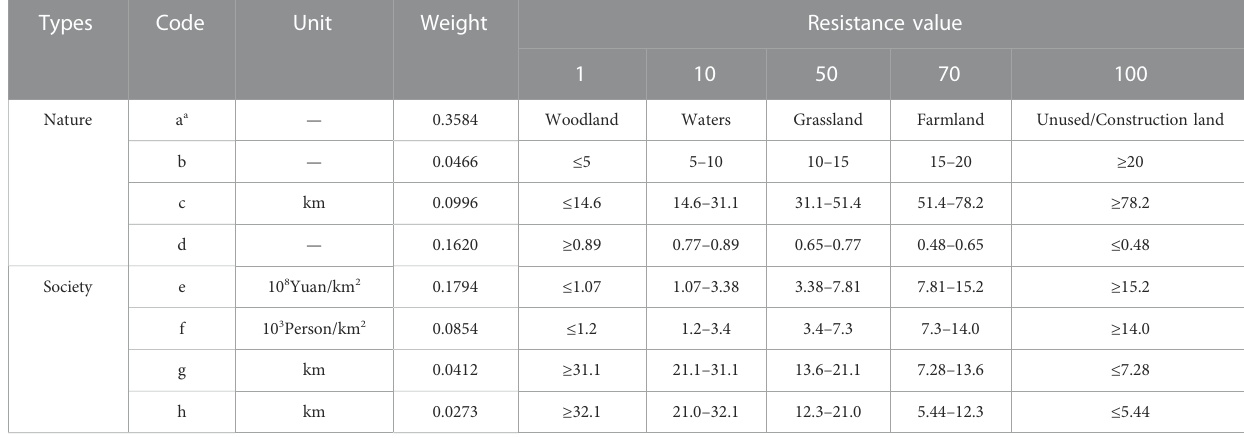
TABLE 3 Resistance factors.